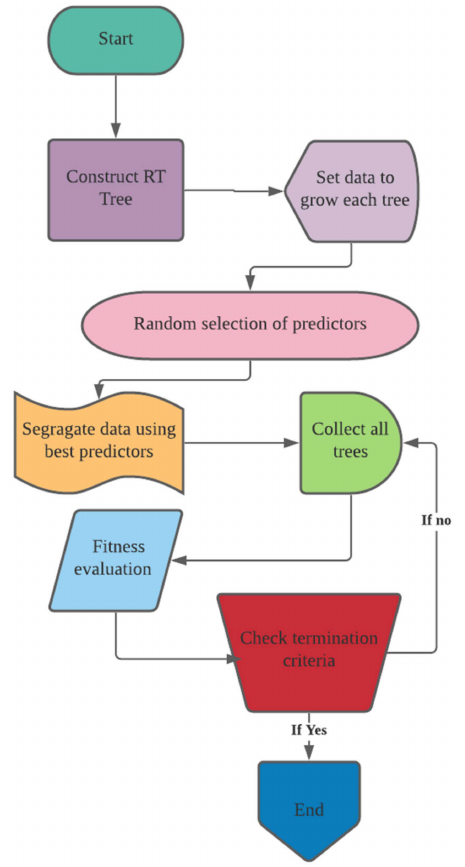
Figure 4. Methodology flowchart for RF